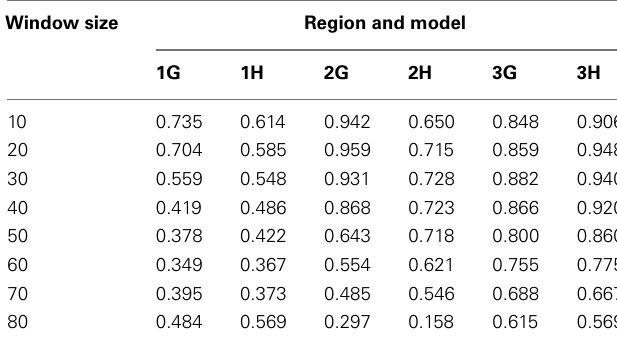
Table 6 | Fraction of simulations in which the window or set of windows with the most significant p -value overlapped the causal sub-region by more than half the window or set’s length.